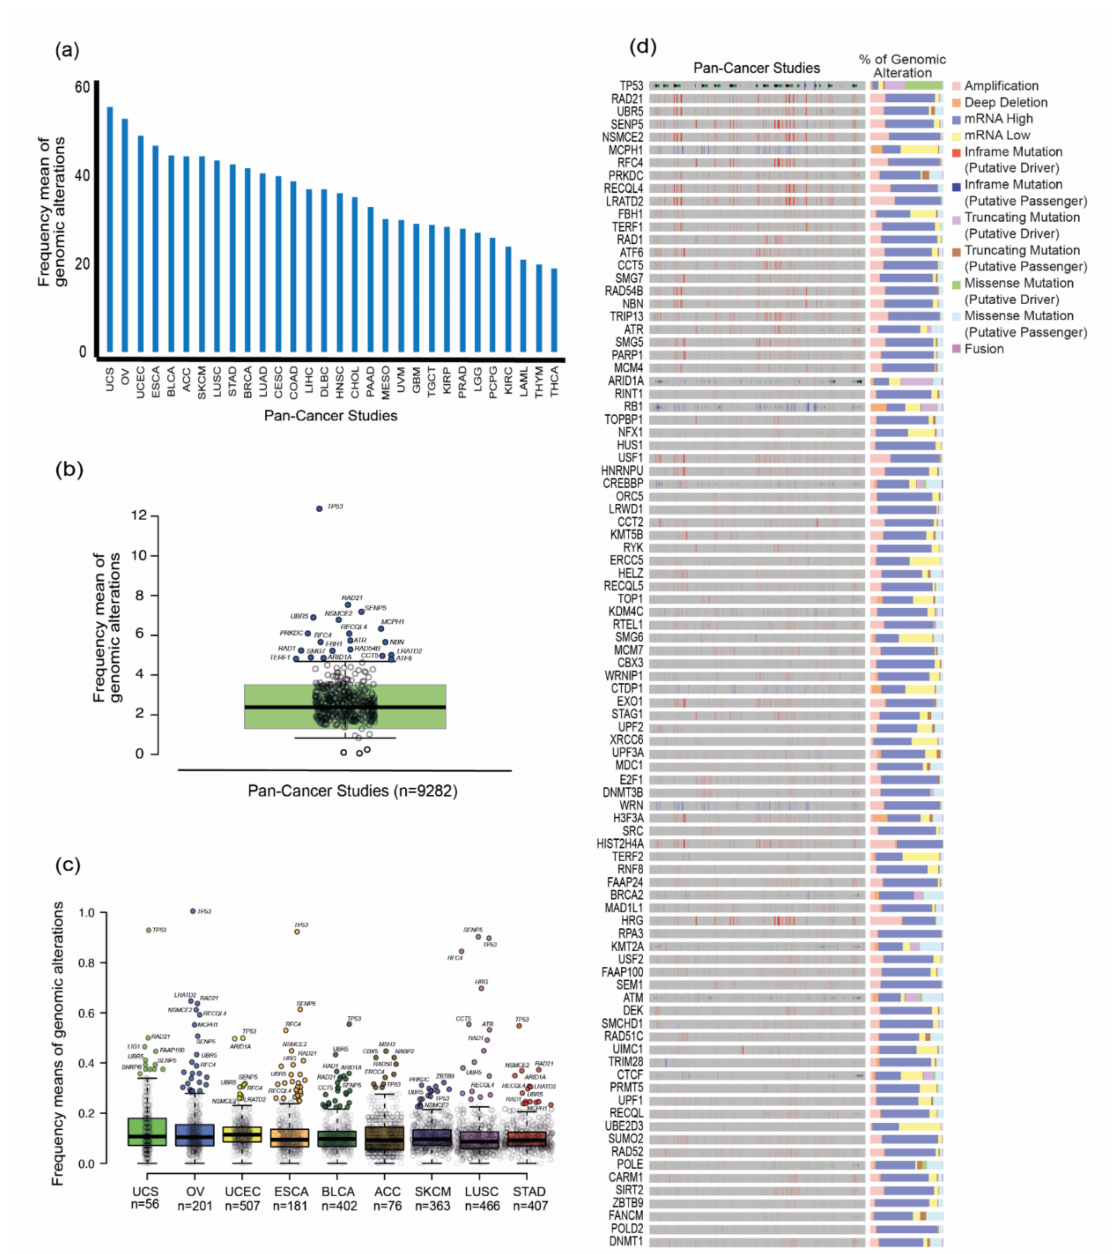
Figure 3. Top altered cancers and oncoprint. ( a ) Shows the most altered cancers according to the frequency means of genomic alterations of the 411 genes previously normalized by the number of samples in each PCA study. ( b ) Shows a boxplot with frequency means of genomic alterations of the 411 genes in all the 31 PCA studies; 20 genes were identified as highly altered and are represented in the blue dots. ( c ) Shows boxplots of the 411 genes with each of the first quartiles of the most altered PCA studies. The unusual altered genes are represented in color dots per each cancer study. ( d ) Shows the oncoprint of the most altered genes across the PCA studies, with the individual genomic alteration’s profile of each gene marked in di ff erent